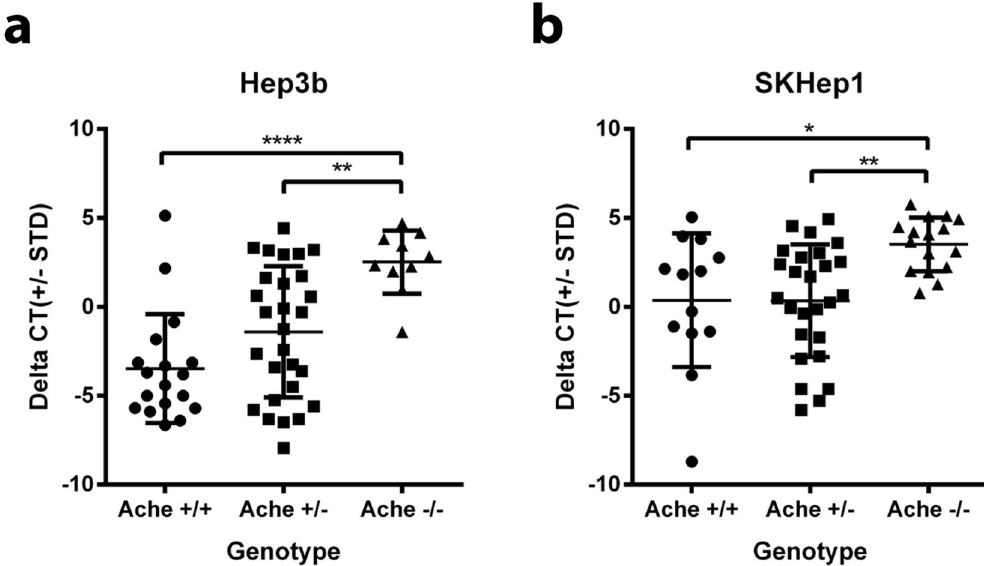
Figure 7. The comparison of the AluYb8 Ct values between genotypes using a qPCR assay. DNA was extracted from 3 dpi larvae injected with liver cancer cell lines (Hep3B and SKHep1) were amplified by qPCRs with using ache N, ache S, and AluYb8 primers (Supplementary Table 1). The Ct value difference ( ∆ Ct) between ache N and ache S primers were used for the genotyping (Supplementary Figure 8). ( a ) For Hep3B (n = 18, 28 and 10 for ache + / + , ache + / − and ache − / − ) normalized Ct values were significantly higher in ache − / − larvae in comparison to both ache + / − and ache + / + larvae ( P = 0.005 and 0.0001, respectively). ( b ) For SKHep1 (n = 13, 26 and 16 for ache + / + , ache + / − and ache − / − ) normalized Ct values were significantly higher in ache − / − larvae in comparison to both ache + / − and ache + / + ( P = 0.004 and 0.017,